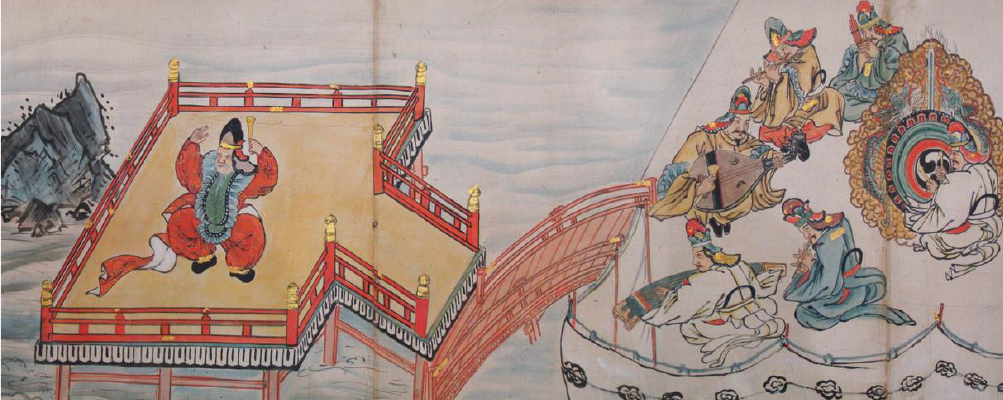
Figure 5. Kotozaki Hachimangū engi 琴崎八幡宮縁起 (The story of Kotozaki Hachiman Shrine, 1491). Kotozaki Hachiman Shrine, Ube City (Yamaguchi prefecture). Courtesy of the Hachiman Project, University of Heidelberg. At https://kjc-sv038.kjc.uni-heidelberg.de/hachiman/#O4616.4/, accessed on 15 June 2022.